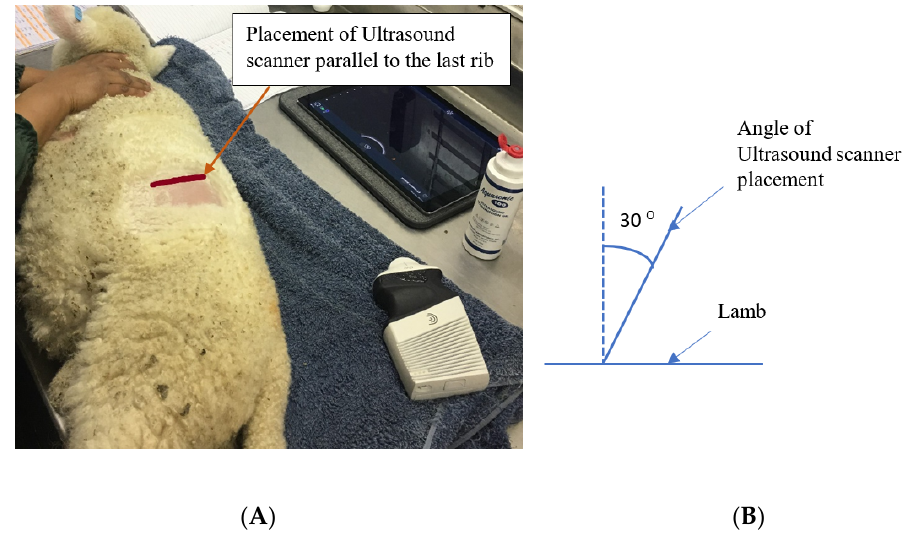
Figure 1. The site ( A ) and angle ( B ) of positioning of Ultrasound scanner to capture rumen images. 2.3. Slaughter